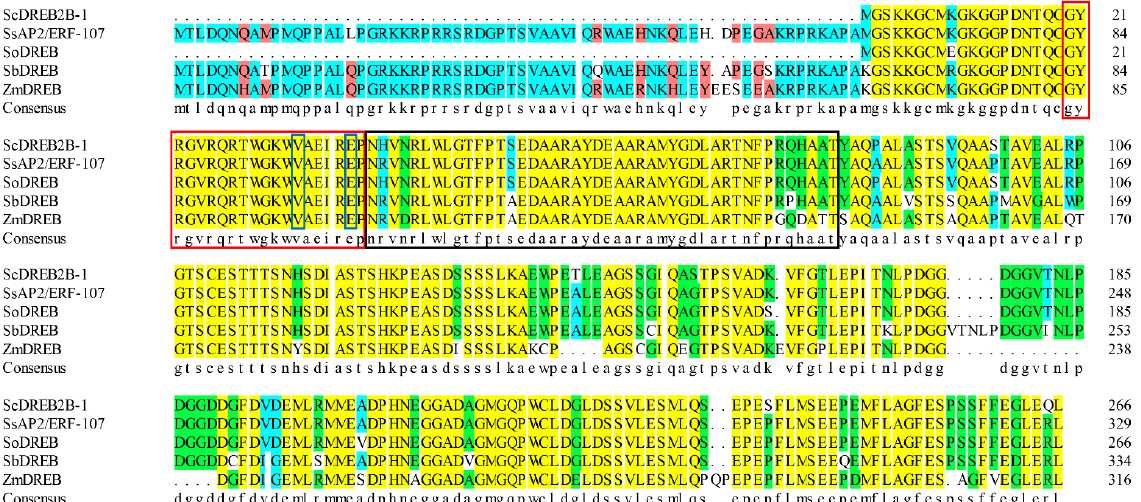
Figure 1. Amino acid sequence alignment of the ScDREB2B-1 protein and its four homologous proteins. Red box: YRG conserved element; black box: RAYD conserved element; blue box: the 14th valine (V14) and 19th glutamic acid (E19) residues in the AP2 conservative domain. SsAP2/ERF-107: Saccharum spontaneum DREB protein; SoDREB: S. officinarum DREB protein; SbDREB: Sorghum bicolor DREB protein; ZmDREB: Zea mays DREB protein. The yellow background showed identical residues; the green background and the blue background were blocks of similar residues; the red background depicted the weakly similar residues; the white background represented non-similar